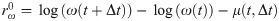
Time evolution of connections’ weights.The weight ωij of a connection between users (i, j) corresponds to the number of emails exchanged by i and j during a whole year. We only consider connections with ω ≥ 12 (see text) (A) Distributions of weights for each one of the years in our dataset (2007-2010). Note that the distribution is stable in time. (B) Distribution of the centered weight logarithmic growth rates rω0=log(ω(t+Δt))-log(ω(t))-μ(t,Δt) for Δt = 1, 2, 3 (dots, squares and diamonds, respectively). Lines show fits to the convolution of a Laplace distribution and a Gaussian distributed noise (see Eq (5)) (parameters Δt = 1: σexp = 0.43, and σG = 0.35, Δt = 2: σexp = 0.50, and σG = 0.47 and Δt = 3: σexp = 0.50, and σG = 0.60). Note that as Δt increases the peaks are rounder and the distributions are slightly wider (see Fig D in S2 File). See Fig B in S2 File for values of the distribution modes μ(t, Δt).